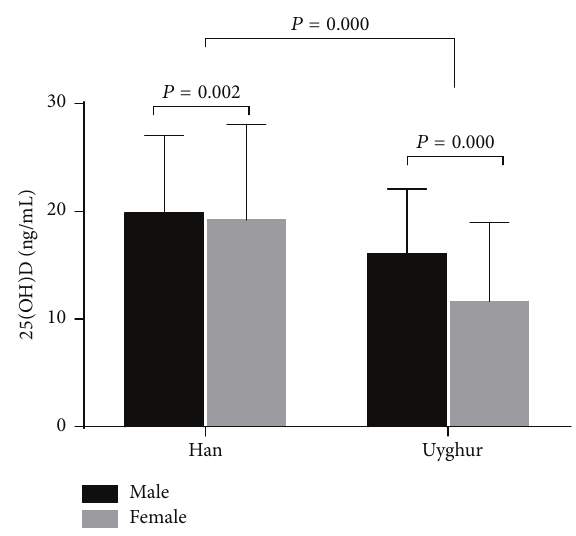
Figure 2: Serum levels of serum 25(OH)D in the study subjects according to the gender and ethnicity.